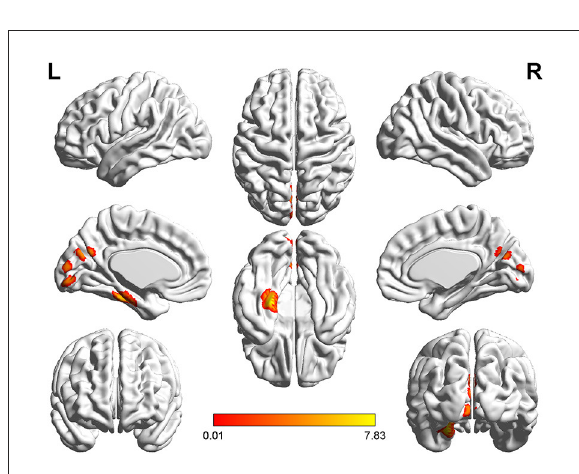
FIGURE4 T -value map of increased gray matter volume in the patients with left acoustic neuroma compared with healthy controls. Compared with healthy controls, the brain regions with increased gray matter volume in the patients with left acoustic neuroma were: the left parahippocampal gyrus, the fusiform, the calcarine, and the cuneus. The statistical threshold was voxel-wise p < 0.001 with cluster-wise FWE corrected p < 0.05 (487 voxels).